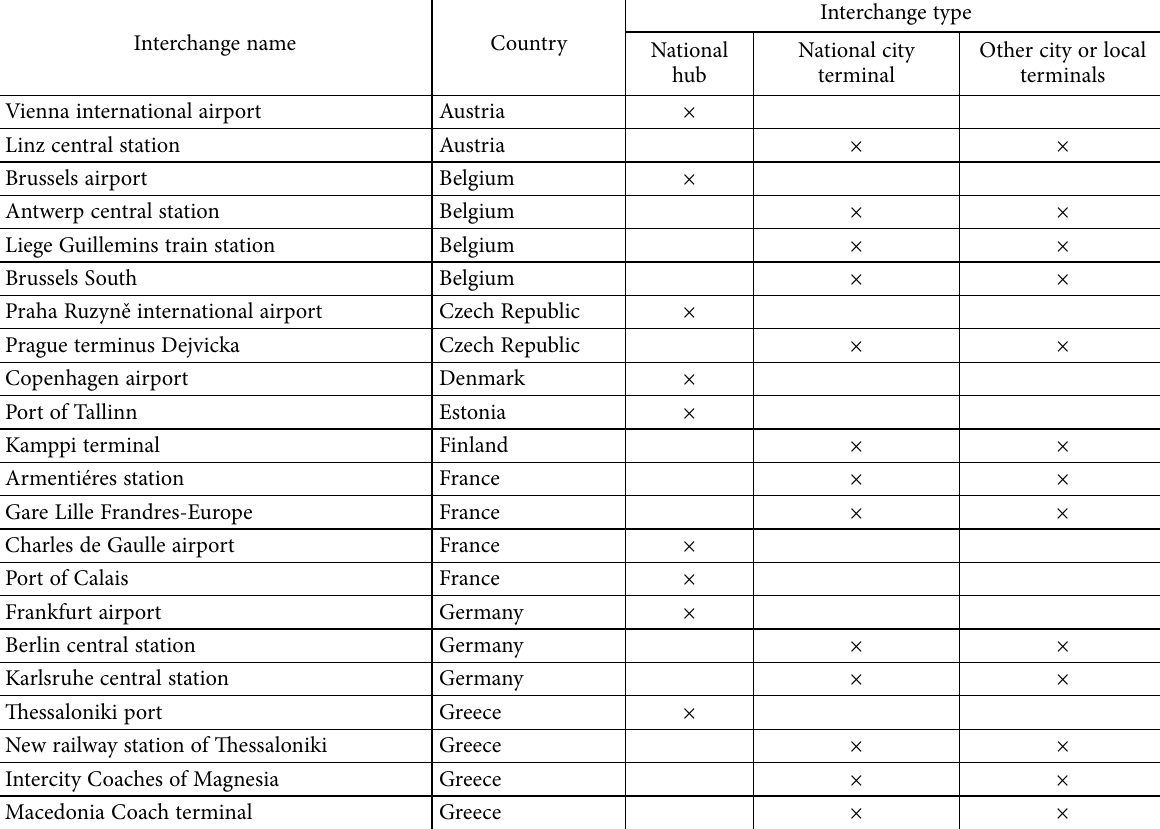
Table 1. Overview of passenger interchanges in European